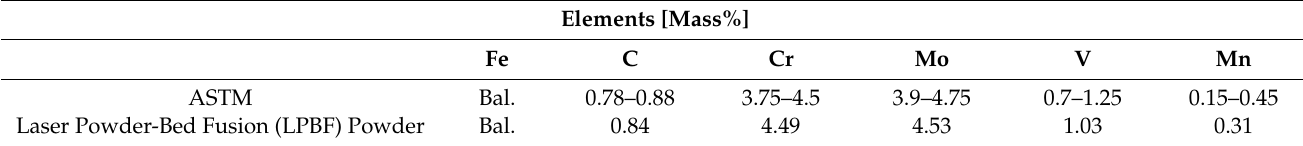
Table 1. Standard chemical composition of M50 (ASTM A600-92a [21]) and the chemical composition of M50 powder in this study. Elements [Mass%] ASTM Laser Powder-Bed Fusion (LPBF)